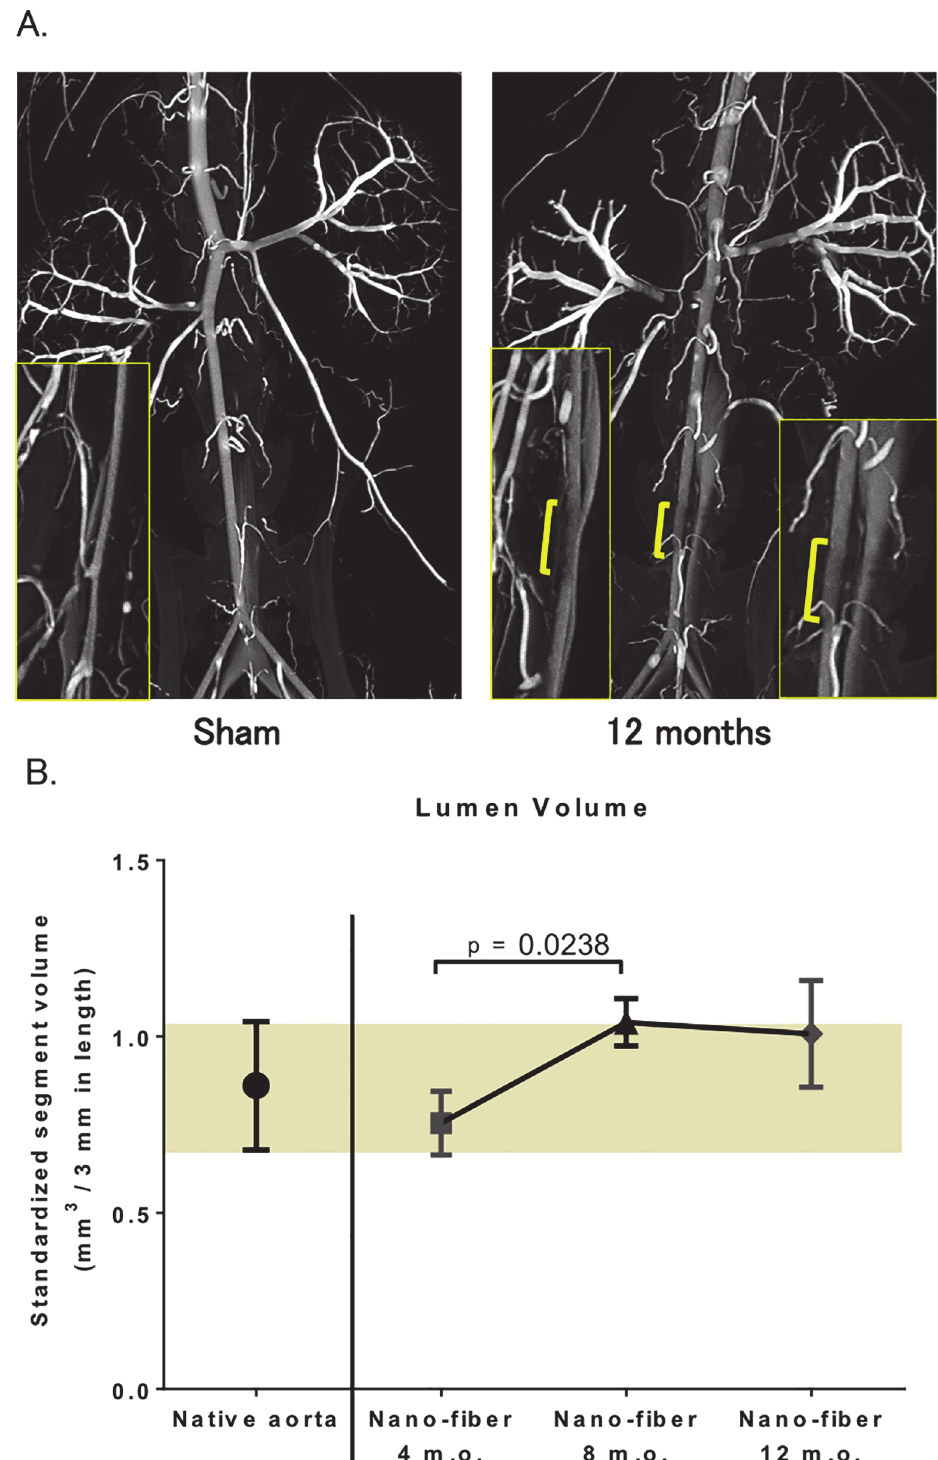
Fig 3. Assessment of TEVG morphometry using microCT angiography demonstrated absence of aneurysmal dilatation or stenosis 12 months after Implantation. A. High resolution post-mortem microCT angiography at 12 months post-implantation. The results indicated smooth endoluminal surface and absence of aneurysmal dilatation or stenosis. Yellow bar indicates approximate location of tissue engineered vascular